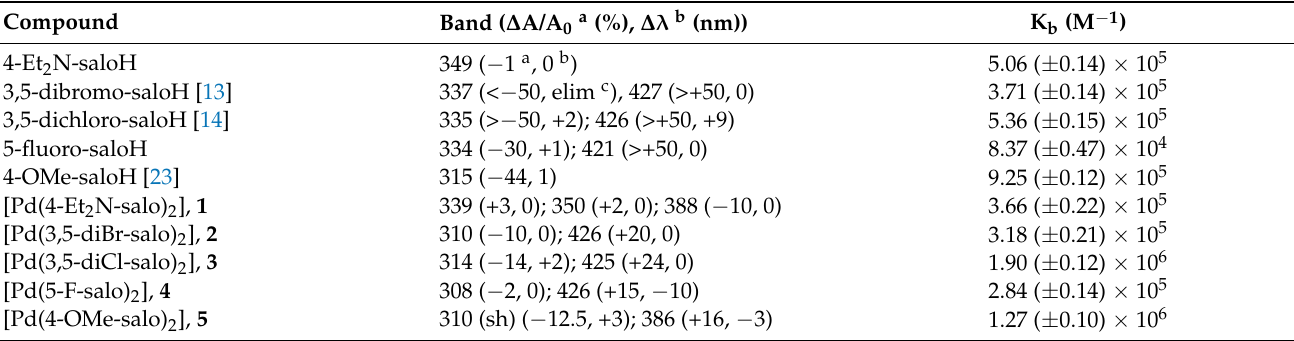
Table 3. Spectral features of the UV-vis spectra of X-saloH and complexes 1 – 5 upon addition of DNA. UV-band ( λ max , in nm) (percentage of hyper-/hypo-chromism ( ∆ A/A 0 , %), blue-/red-shift of the λ max ( ∆ λ , in nm) and the corresponding DNA-binding constants (K